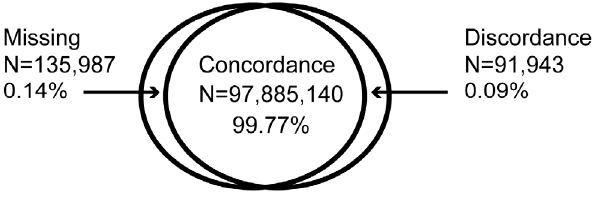
Figure 1. Results of CHARGE exome chip genotype calls compared to exome sequence data in 530